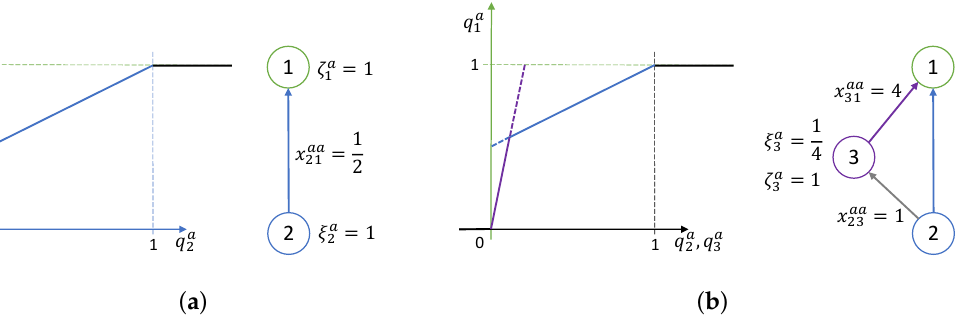
Figure 4. Example of structures for modeling ( a ) linear and ( b ) nonlinear service degradation